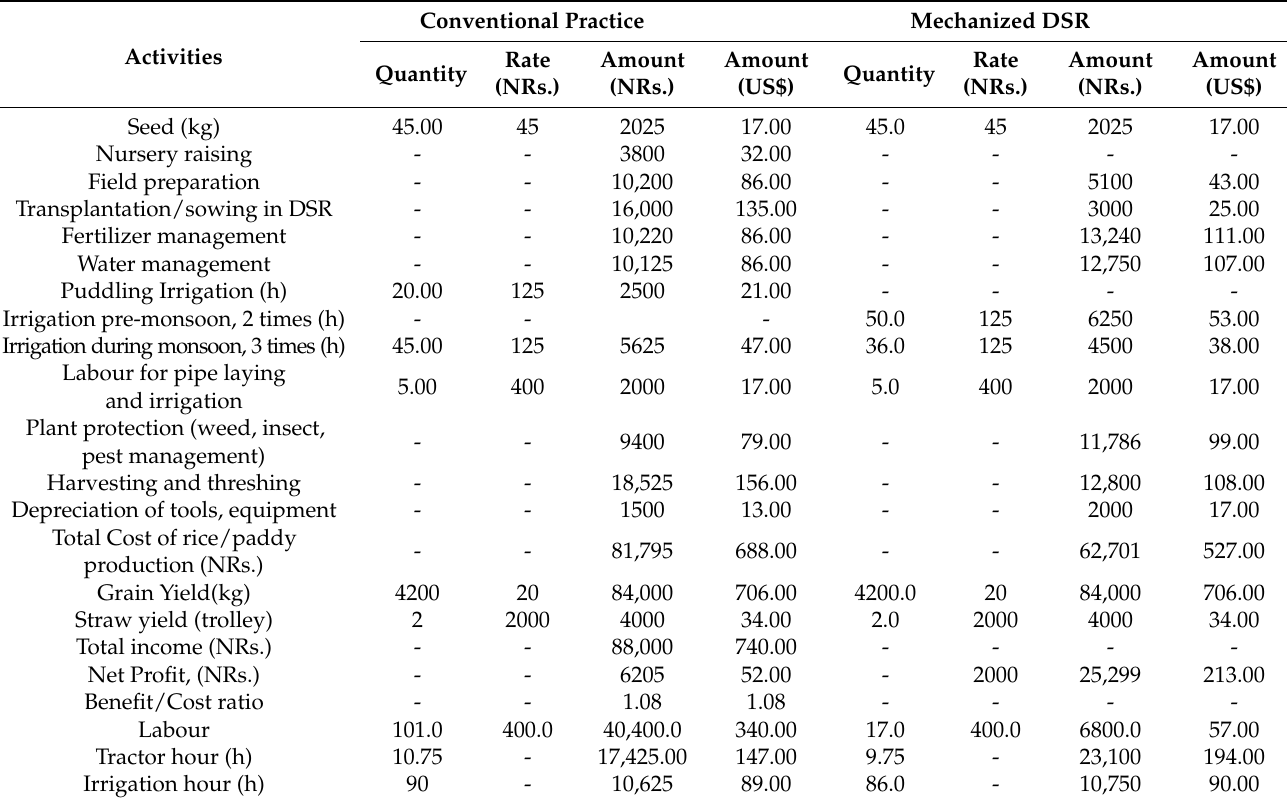
Table 4. Comparison of the cost–benefit analysis of the area using DSR and the area using the traditional puddled system of rice cultivation,